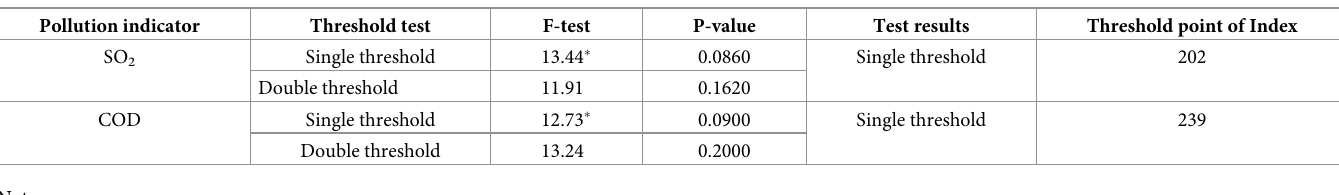
Table 6. Threshold effect test results.